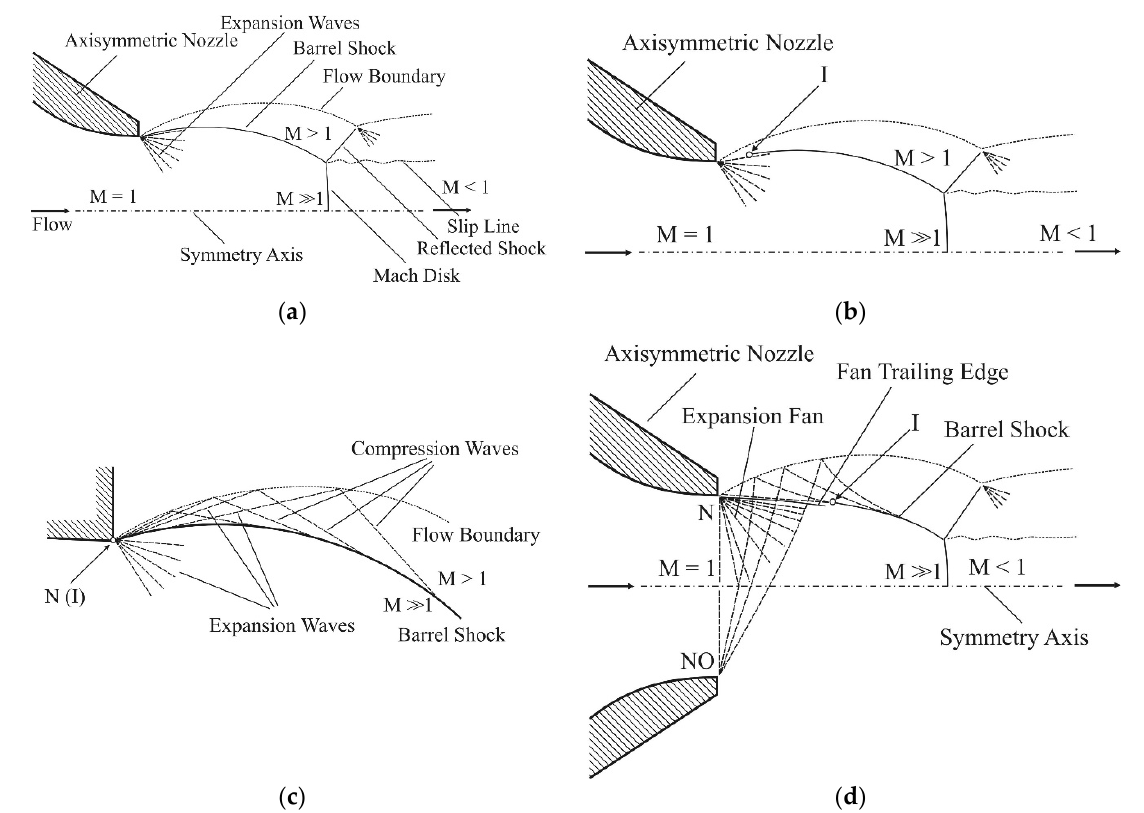
Figure 1. Structure of the flow in the first “barrel” of a sonic underexpanded jet: ( a ) the flow diagram, according to [1–8]; ( b ) the flow diagram, according to [9–13]; ( c ) a flow diagram illustrating the barrel-shock formation mechanism, according to [2–5,8]; ( d ) a flow diagram illustrating the barrel-shock formation mechanism, according to [10].